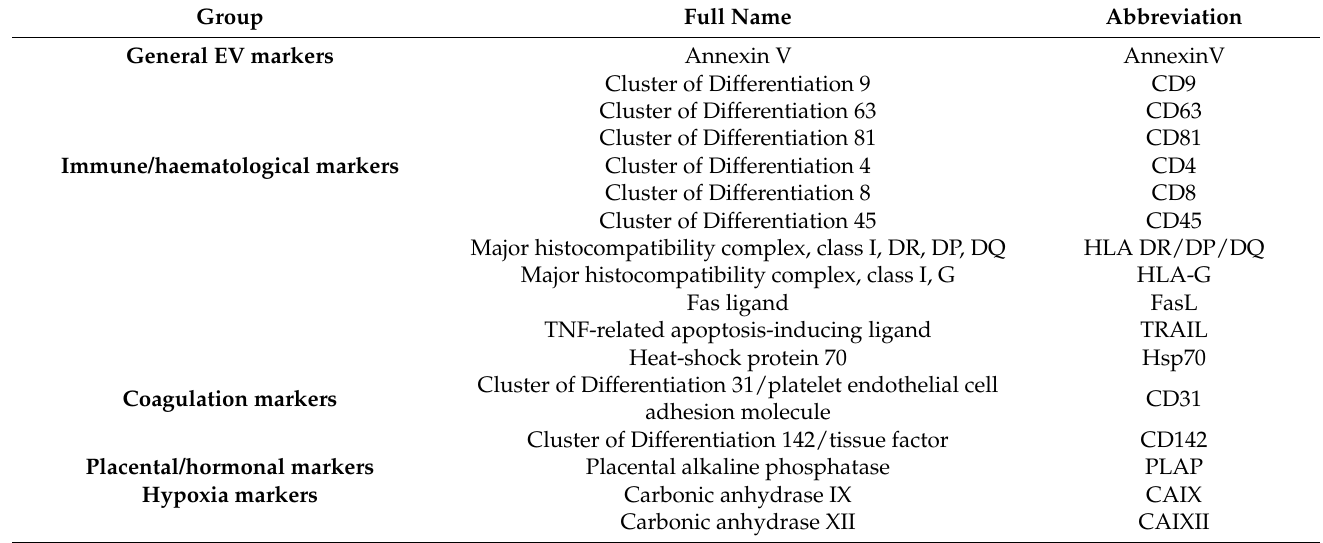
Table 1. Overview of the 17 EV markers used in this study (see Appendix A for clone and producent).